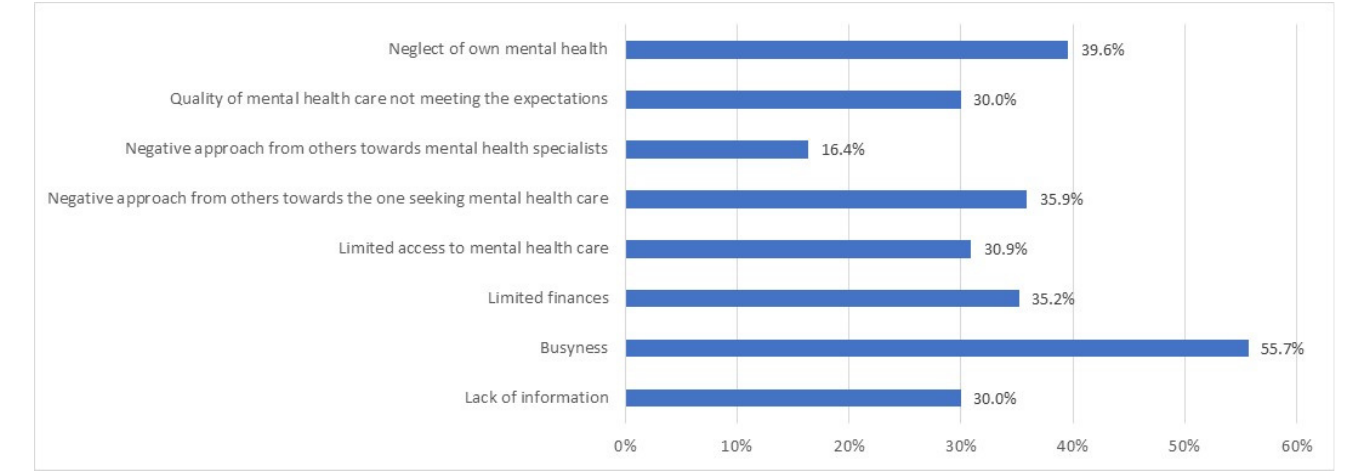
Figure 2. Obstacles to the use of mental health services among health care and pharmacy specialists.